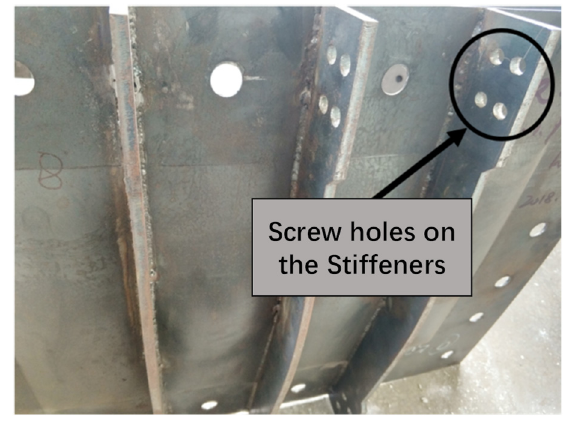
Figure 3. Screw hole on the stiffeners.